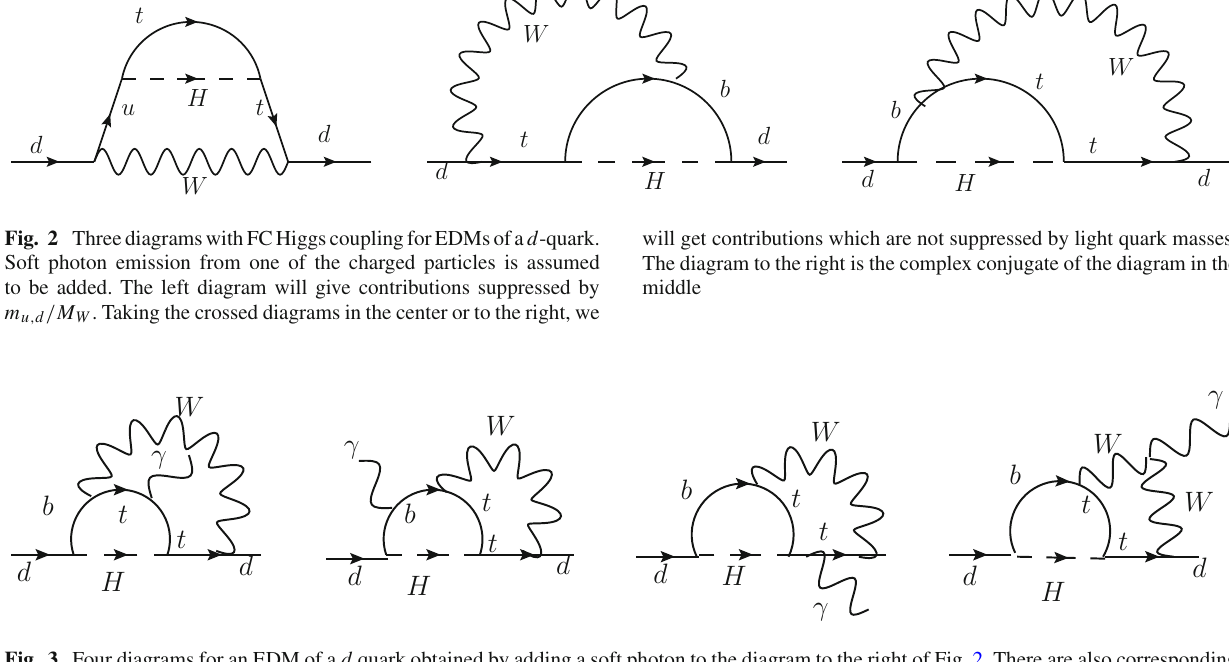
Fig. 3 Four diagrams for an EDM of a d quark obtained by adding a soft photon to the diagram to the right of Fig. 2. There are also corresponding diagrams where the W -boson is replaced by an unphysical Higgs-boson within Feynman gauge